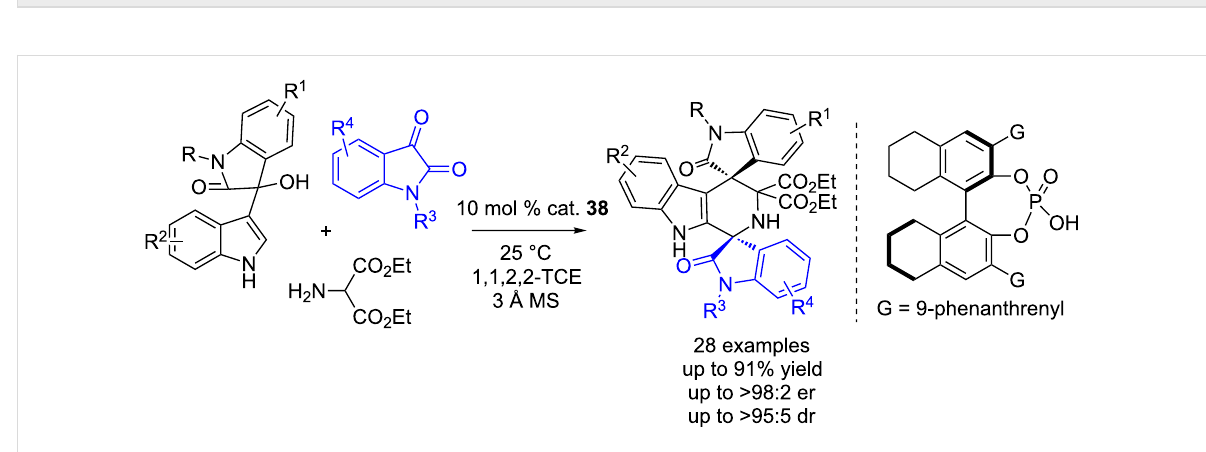
Scheme 55: CPA-catalyzed three-component cascade Michael/Pictet–Spengler reactions of 3-indolylmethanols and azomethine